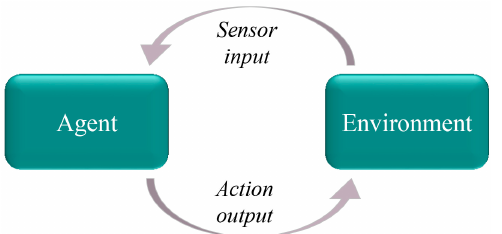
Figure 1. Abstract view of an agent in its environment adapted from [14].